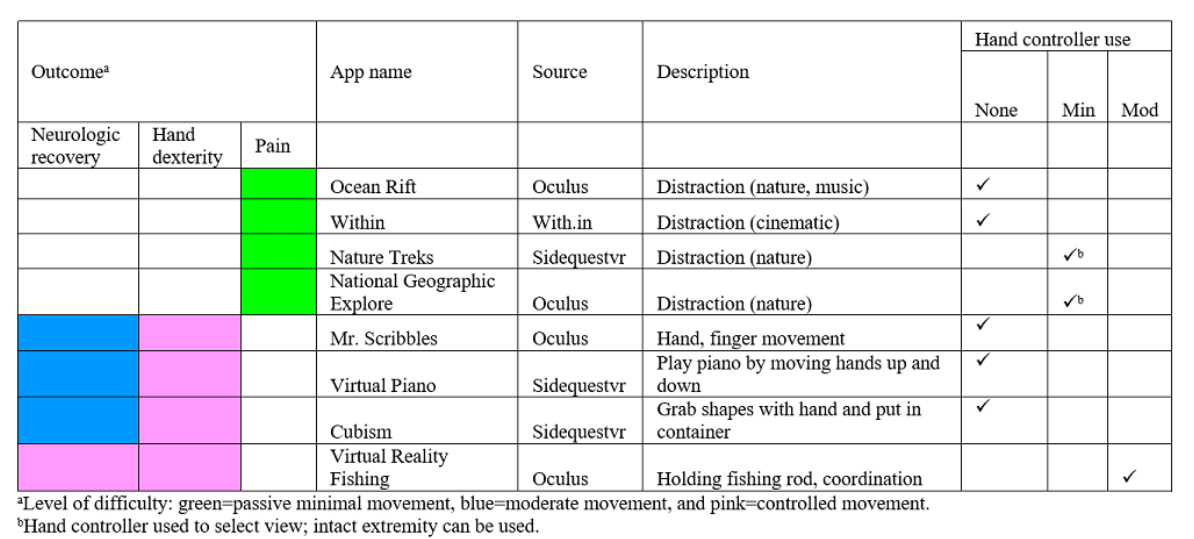
Figure 2. Apps in the virtual reality toolkit for Oculus